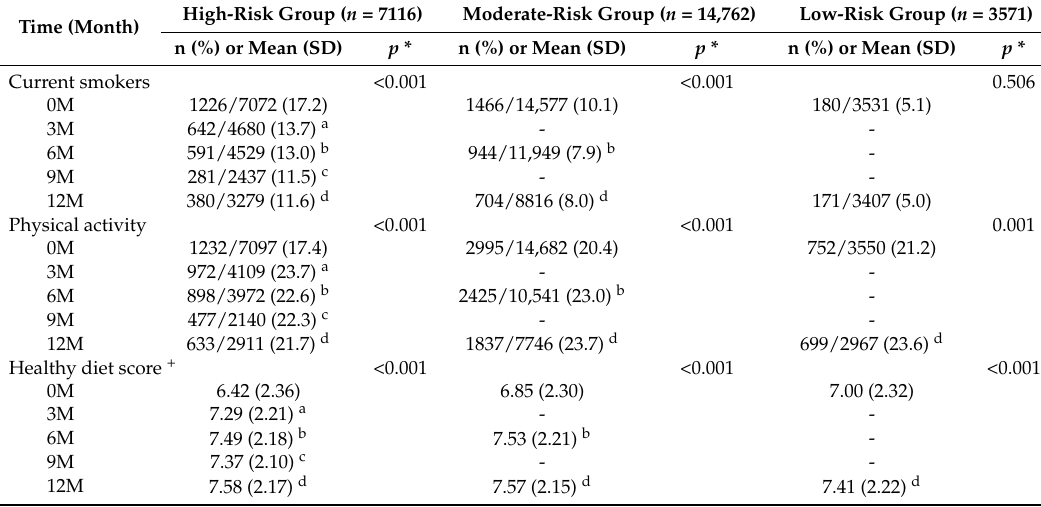
Table 4. Changes in behavioral lifestyle factors over the SMESY intervention ( N =